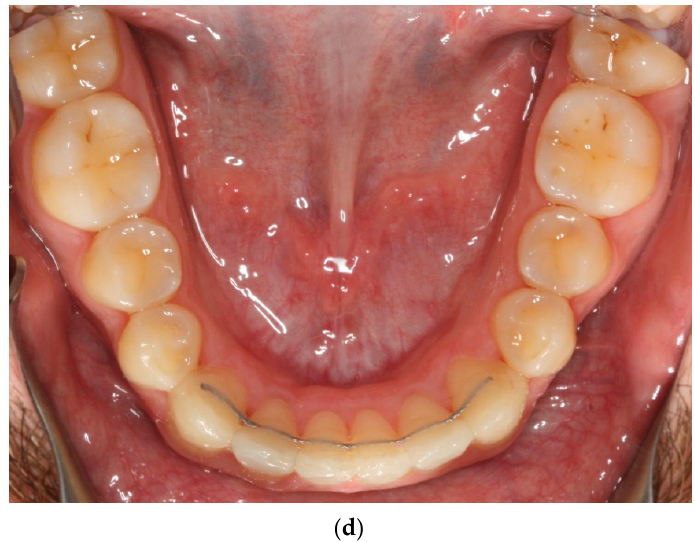
Figure 6. Fixed permanent retainer. ( a ) Upper canine to canine flexible cylindrical wire, ( b ) Lower canine to canine flexible cylindrical wire, ( c ) Lower canine and canine non flexible cylindrical wire, ( d ) Lower canine to canine flattened wire